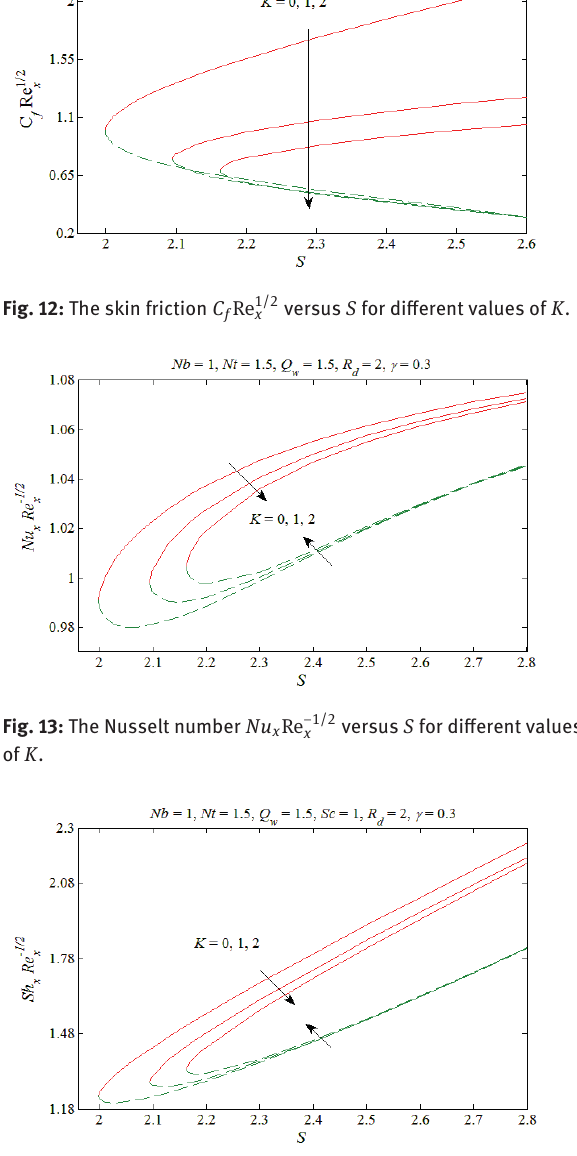
Fig. 14: The Sherwood number Sh x Re −1/2 x versus S for different val- ues of K